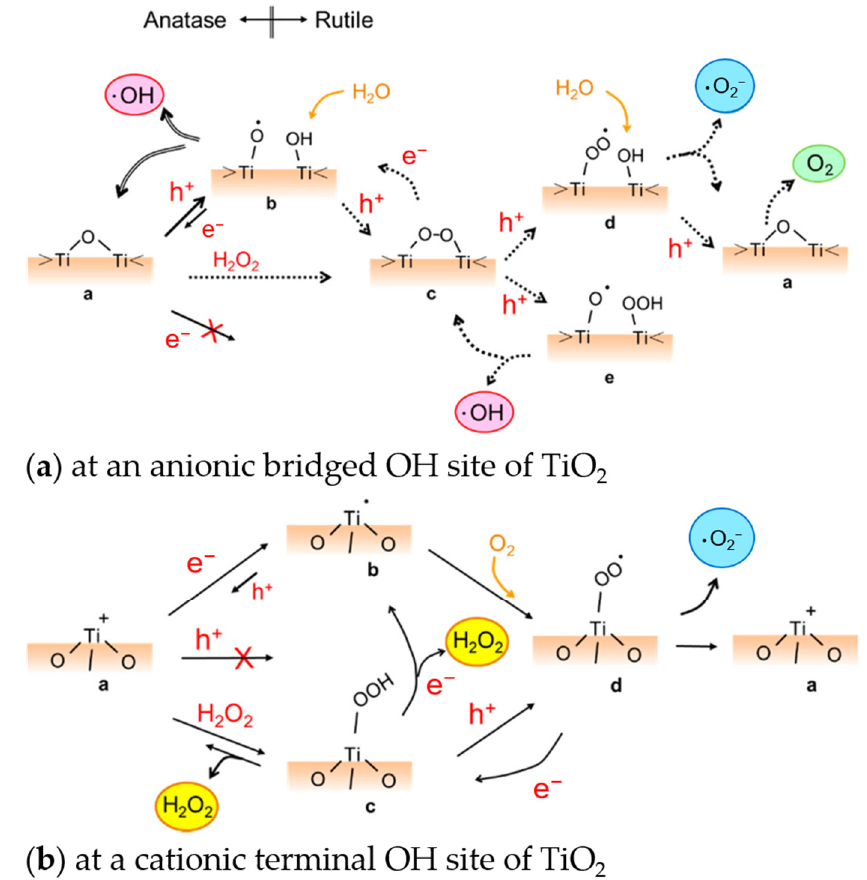
Figure 2. Photocatalytic reaction pathways on TiO 2 proposed ( a ) at a bridge OH site and ( b ) at a terminal OH site. Reprinted (adapted) with permission from Nosaka, Y., Nosaka, A. Understanding